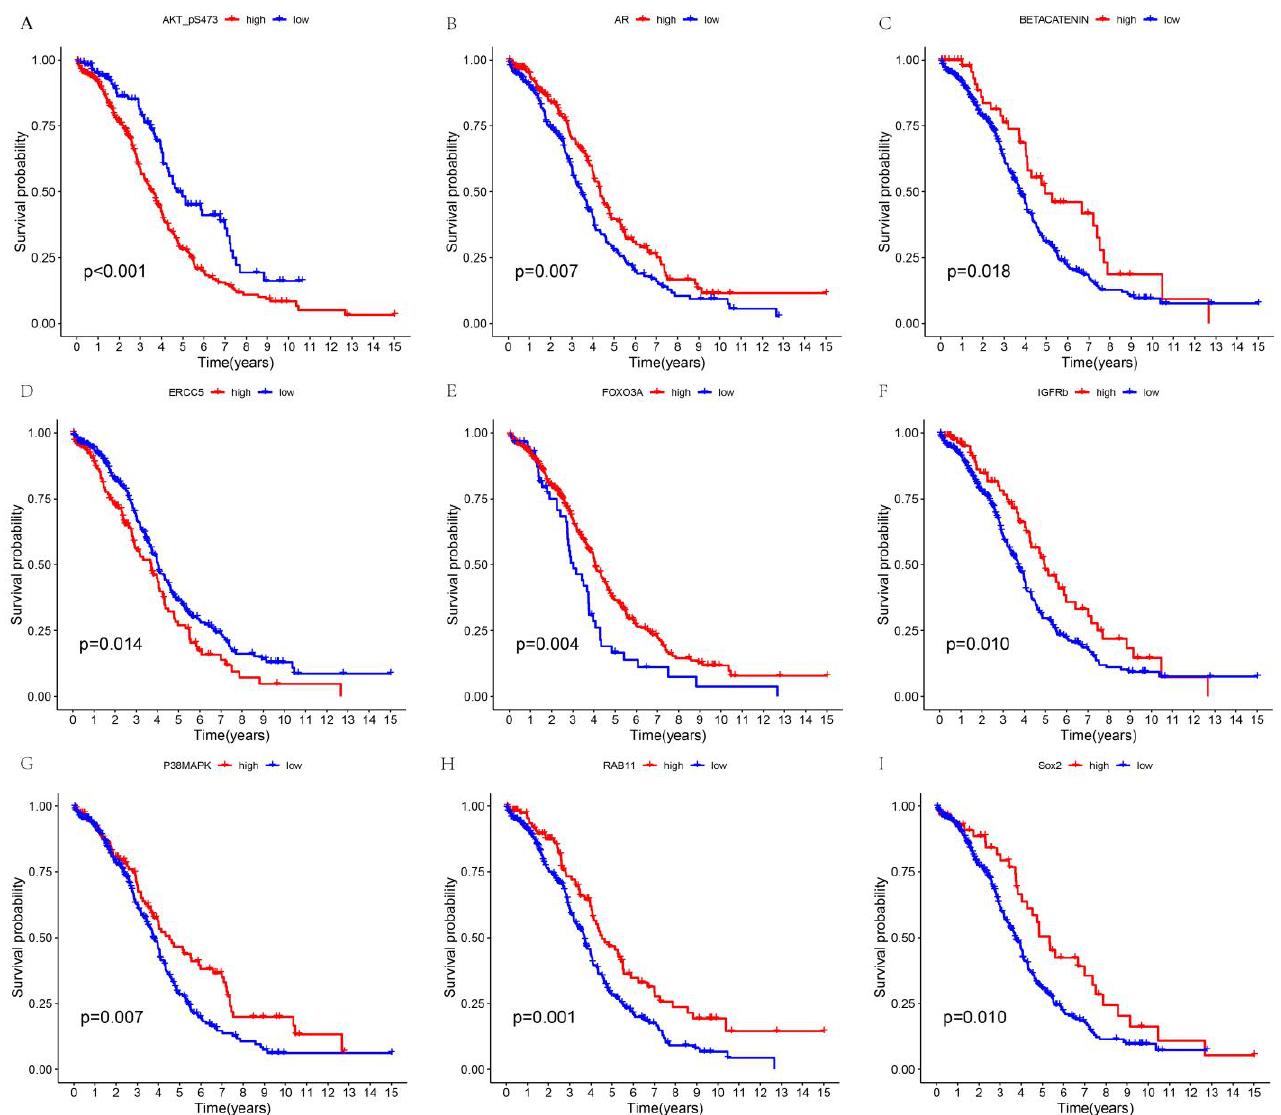
Figure 5. Kaplan–Meier survival curve of overall survival (OS) between high and low expression of the nine protein signatures. ( A ) Kaplan–Meier survival curve of OS between high- and low-expression of AKT_pS473.( B ) Kaplan–Meier survival curve of OS between high- and low-expression of AR. ( C ) Kaplan–Meier survival curve of OS between high- and low-expression of BETACATENIN. ( D ) Kaplan–Meier survival curve of OS between high- and low-expression of ERCC5. ( E ) Kaplan–Meier survival curve of OS between high- and low-expression of FOXO3A. ( F ) Kaplan–Meier survival curve of OS between high- and low-expression of IGFRb. ( G ) Kaplan–Meier survival curve of OS between high- and low-expression of P38MAPK. ( H ) Kaplan–Meier survival curve of OS between high- and low-expression of RAB11. ( I ) Kaplan–Meier survival curve of OS between high- and low-expression of Sox2.